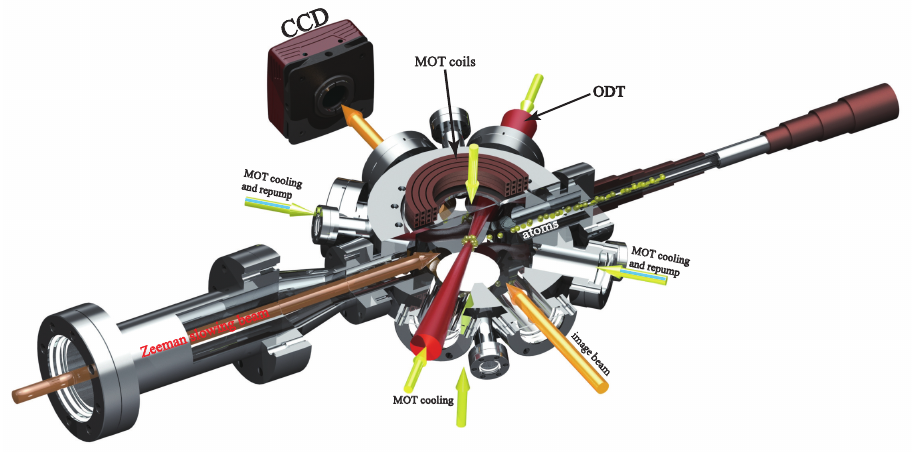
Figure 1. Experimental apparatus of the science chamber and a part of the Zeeman slower. The science chamber is an octagonal chamber with 12 viewports. Magneto-optical trap (MOT) cooling beams (yellow arrows) and repump beams (blue line in yellow arrows) are coupled together. The Zeeman slowing beam (brown arrow) is used to decelerate the ejected atoms (yellow ball). A focused ODT (red arrow) along a cooling beam captures the atoms. The orange arrows represent the image